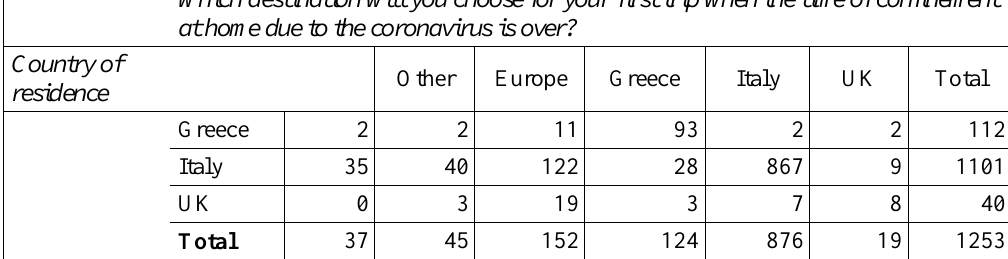
Table 2: Contingency Table: “Country of Residence” – “Preferred Destination for the First